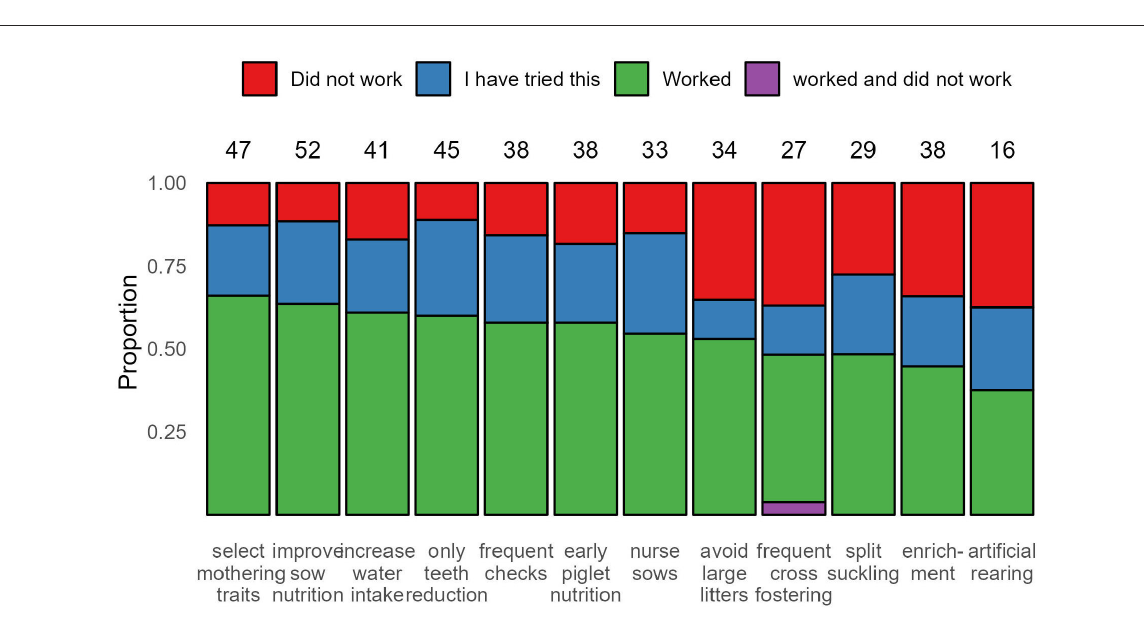
FIGURE2 Proportion of response selections (“Did not work”, “I have tried this”, “Worked” or “Worked and did not work”) to the question: What measures have you tried other than teeth reduction to solve your problems, and which ones worked/did not work? Counts of the total number of respondents who selected each measure (including “I have tried this,” “Did not work” and “Worked”) is shown above the bars.